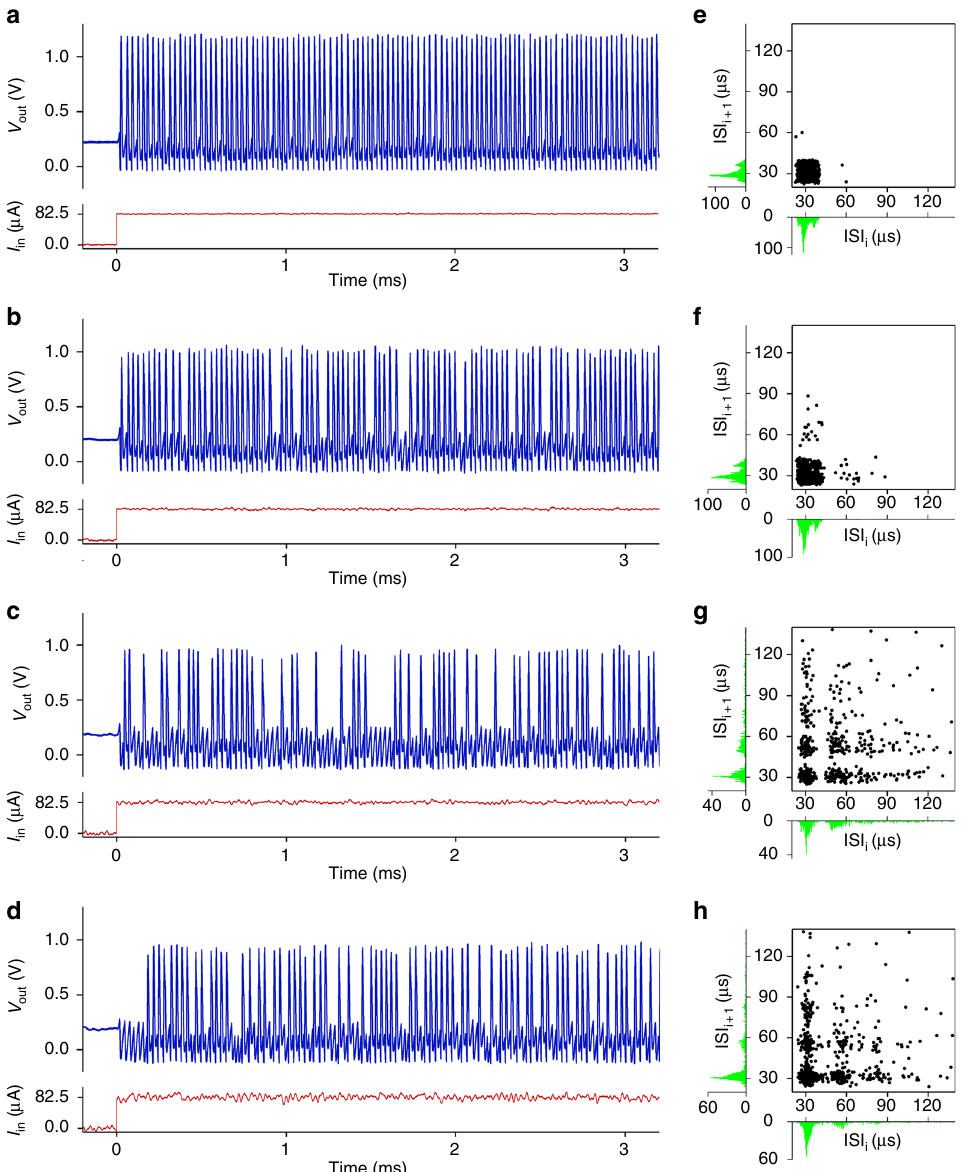
Fig. 6 Stochastically phase-locked fi ring (skipping) in a tonic VO 2 active memristor neuron. a – d Tonic spike trains excited by an input d.c. current of 82.5 µ A amplitude and 35 ms duration. For clarity, only the initial sections of ~3 ms duration are displayed. White noise signals with 5 µ A 50 µ A pp peak-to-peak values, respectively, are added to the current input to study its impact on the fi ring pattern and the correlation between consecutive interspike intervals (ISIs). e – h Joint interspike interval (JISI) scatter plots (aka return maps) of the spike trains shown in ( a – d ). Also shown are the histograms of the ISI distributions. The numbers of spikes used to generate the JISI plots are 1149, 1113, 620, and 754,